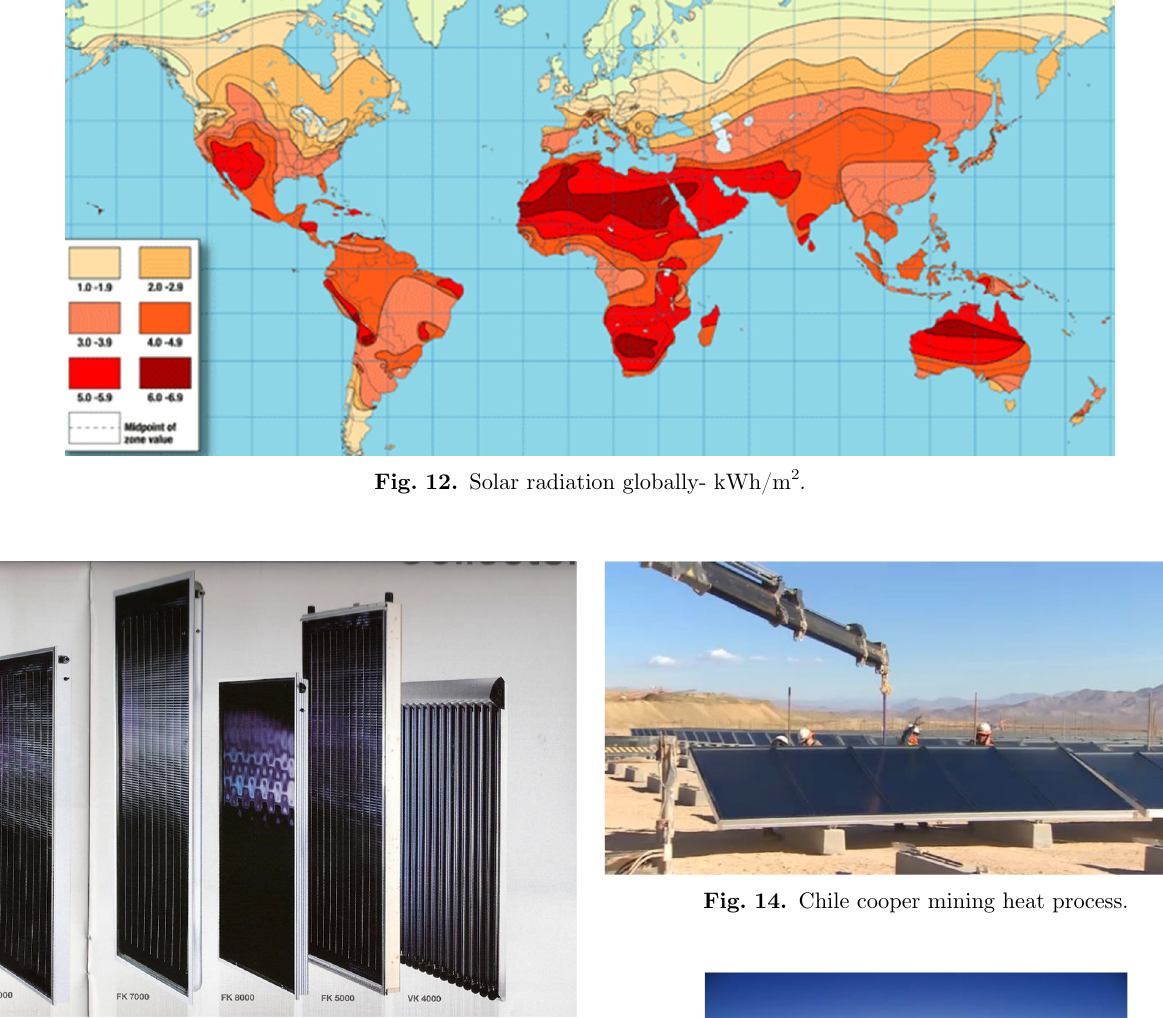
Fig. 13. Some of the recent fl at plate collectors made by an Austrian Company [21].